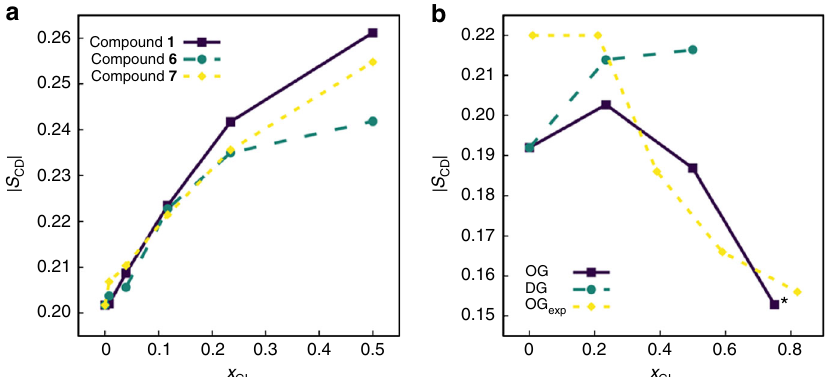
Fig. 5 Effect of alkyl glycosides on phospholipid acyl chain ordering. a Deuterium order parameters at the sixth methylene group of DMPC, averaged over both sn -1 and sn -2 chains, as a function of the respective glycoside molar fraction for compounds 1 , 6 , and 7 . b Control deuterium order parameters at the seventh methylene group of DMPC in the presence of octyl β - D -glucopyranoside (OG) or dodecyl β - D -glucopyranoside (DG). Experimental data shown have been determined for multilamellar bilayer dispersions containing DPPC and OG at 45 °C 30 . *For x OG = 0.75, the bilayer structure distorts signi fi cantly by the end of the simulation